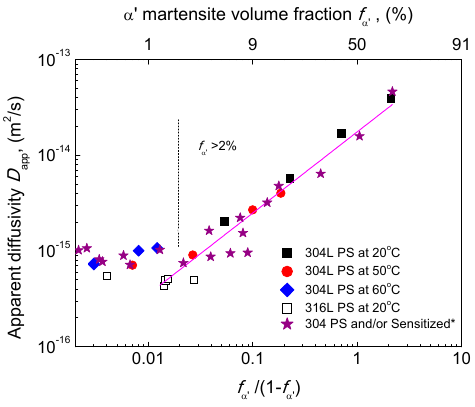
Figure 13. Relation between log D app and log [ f α (cid:48) / ( 1 − f α (cid:48) )] . (*: These data were obtained for a 304 steel in another ongoing study. The steel was firstly prestrained and then submitted to sensitization for different times to vary the content of pre-existing α (cid:48)